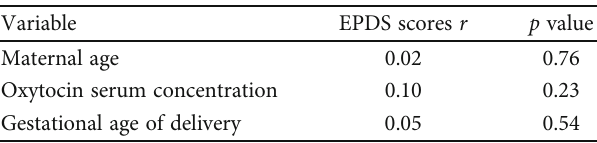
Table 2: Pearson product-moment correlation to assess the correlation between Edinburgh Postnatal Depression Scale (EPDS) scores with maternal age, serum oxytocin concentration, and gestational age of delivery ( N = 172 ).